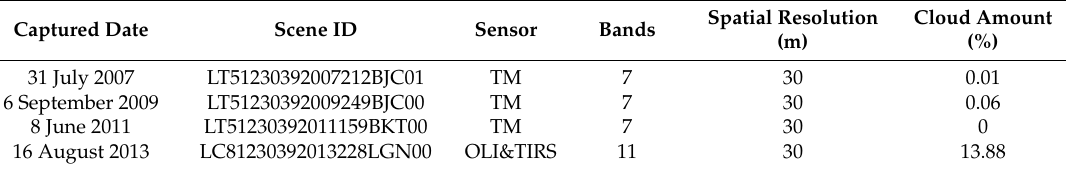
Table 1. Landsat images used in this research.